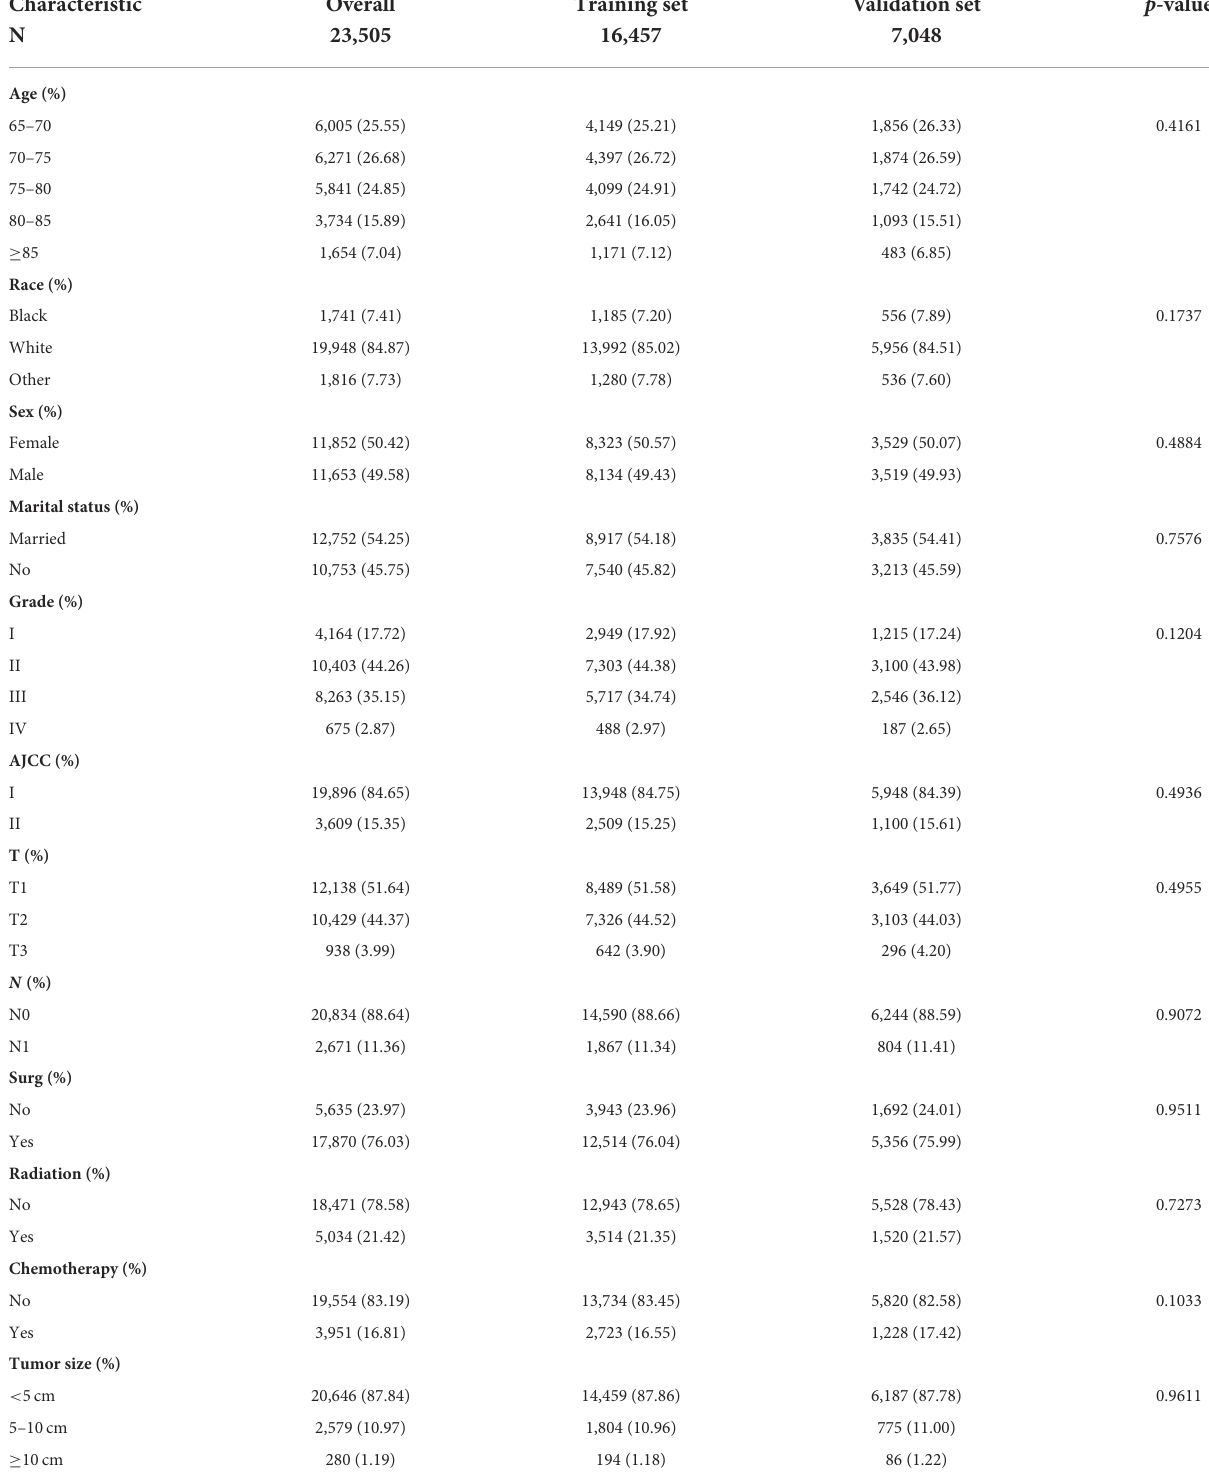
TABLE 1 Clinicopathological characteristics of elderly lung cancer patients—the training group and the validation group. Characteristic Overall Training set Validation set p